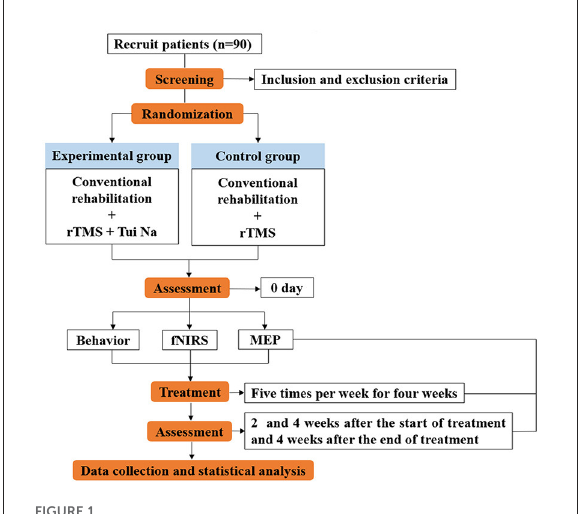
FIGURE1 Summary of the study